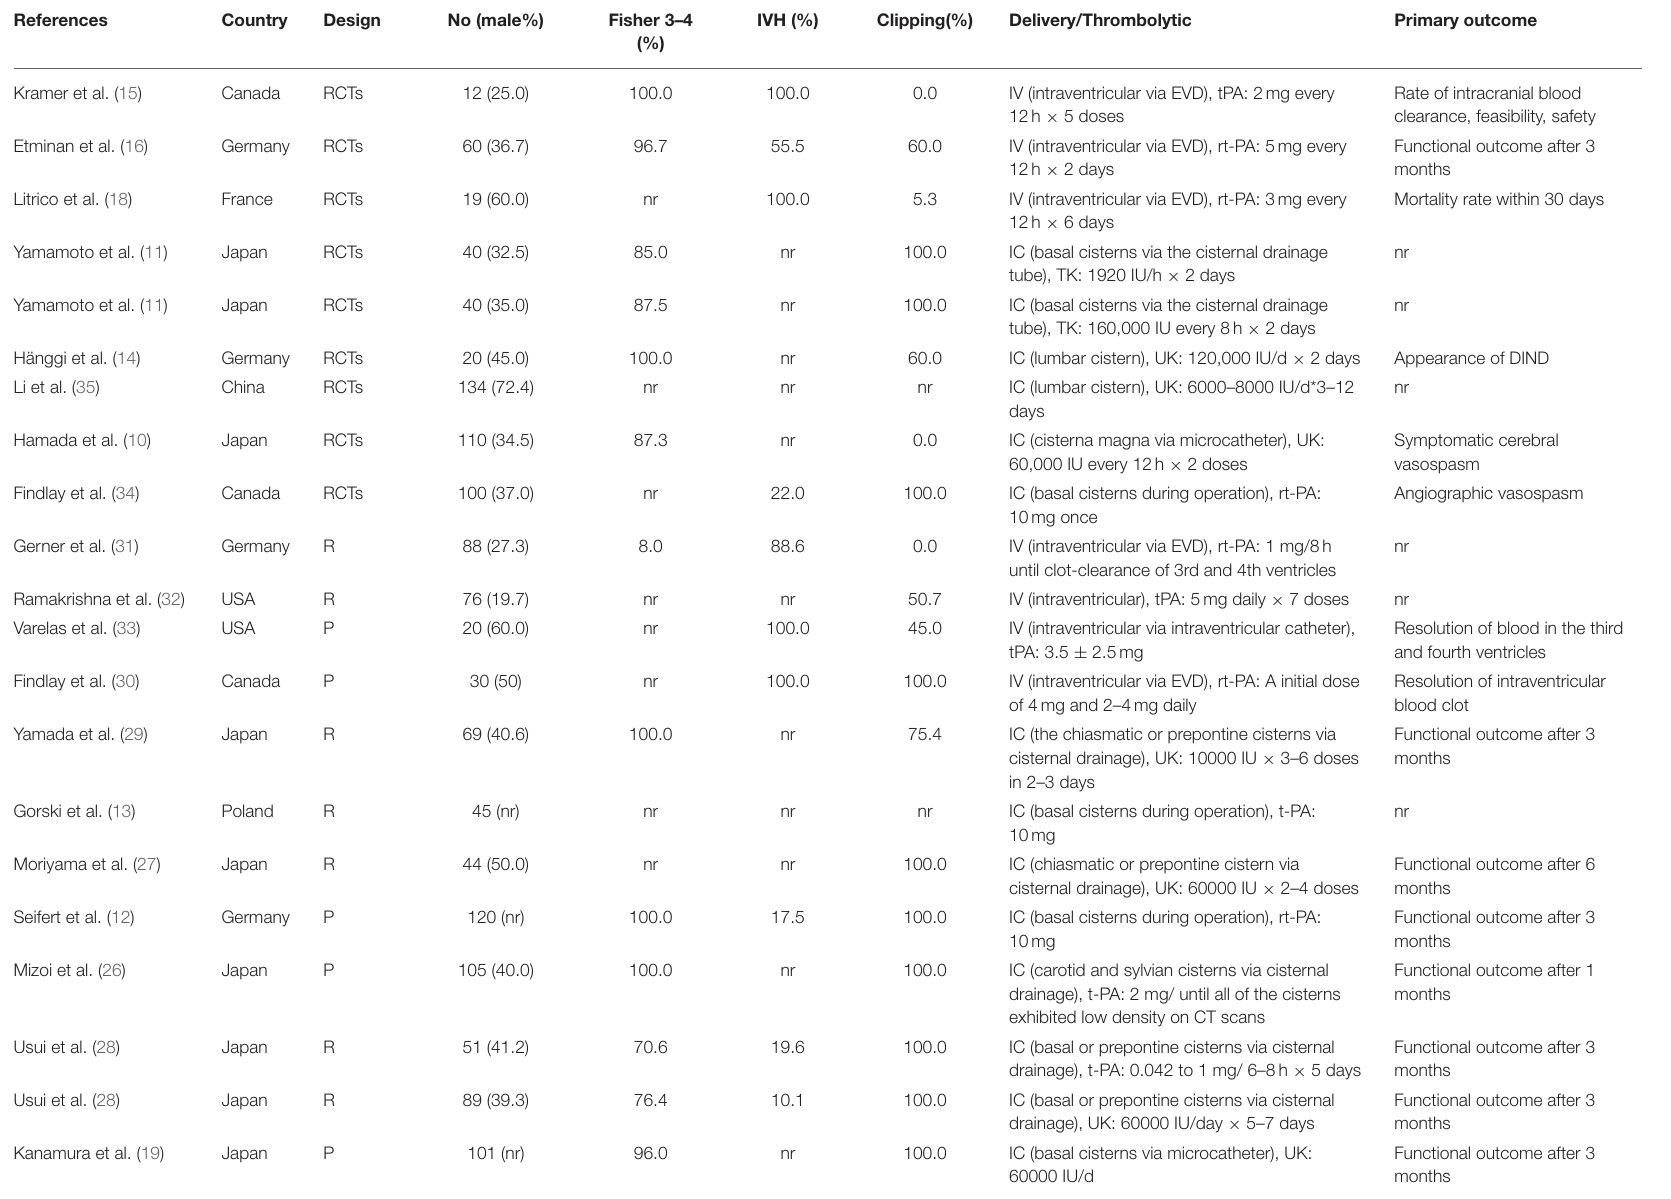
UK, urokinase; TK, Tisokinase; R, retrospective; P, prospective; RCTs, randomized controlled trials; Data are number (%), mean (SD) or median (range); IC, intracisternal fibrinolysis; IV, intraventricular fibrinolysis; n.r., not